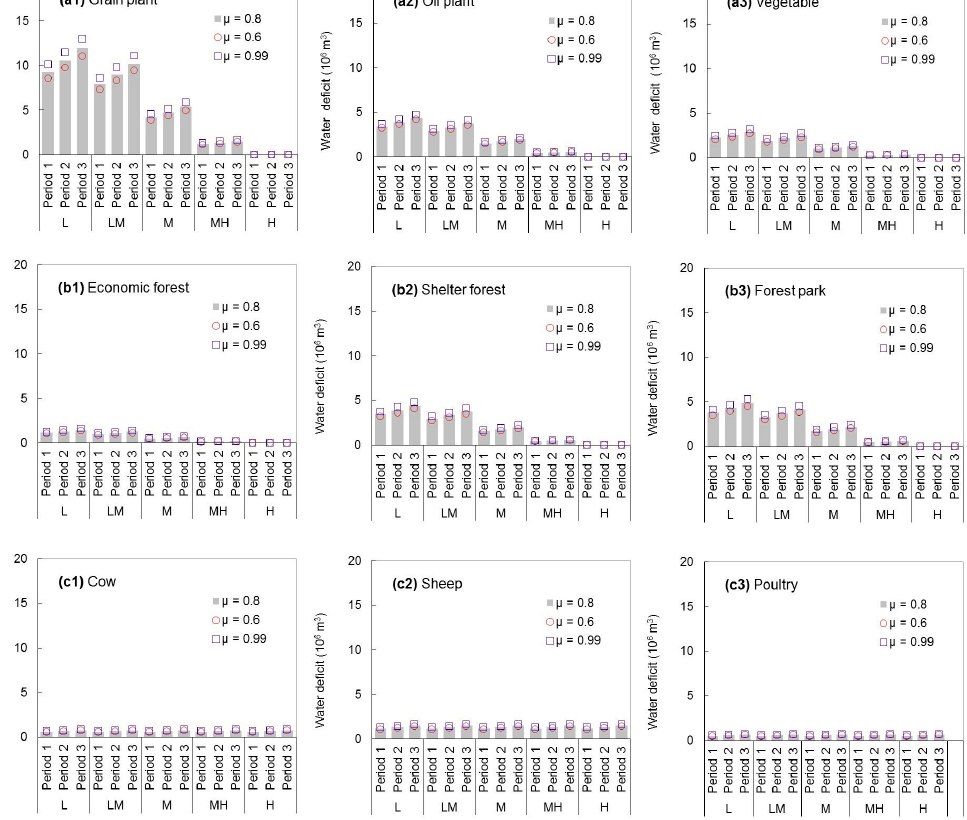
Figure 5. Ecological benefits from AEP under case 1 when µ level is 0.99.